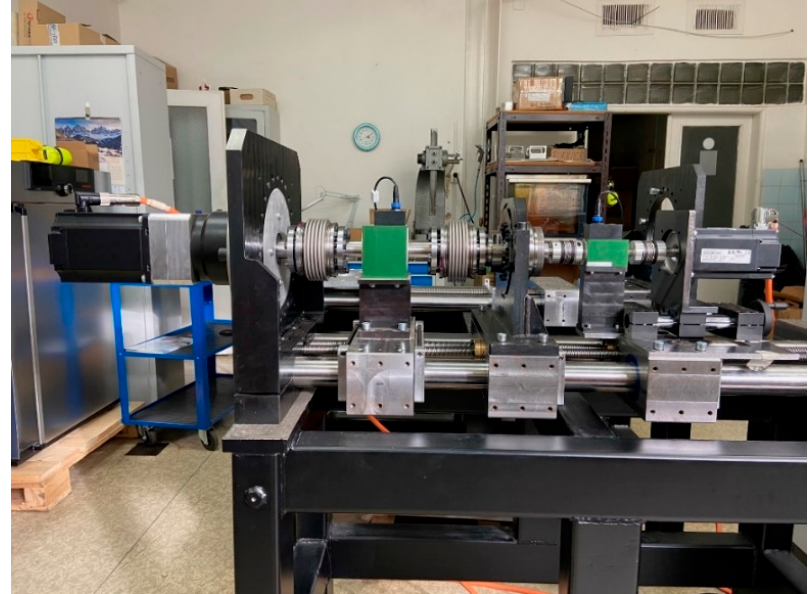
Figure 7. View of the stand in configuration B.